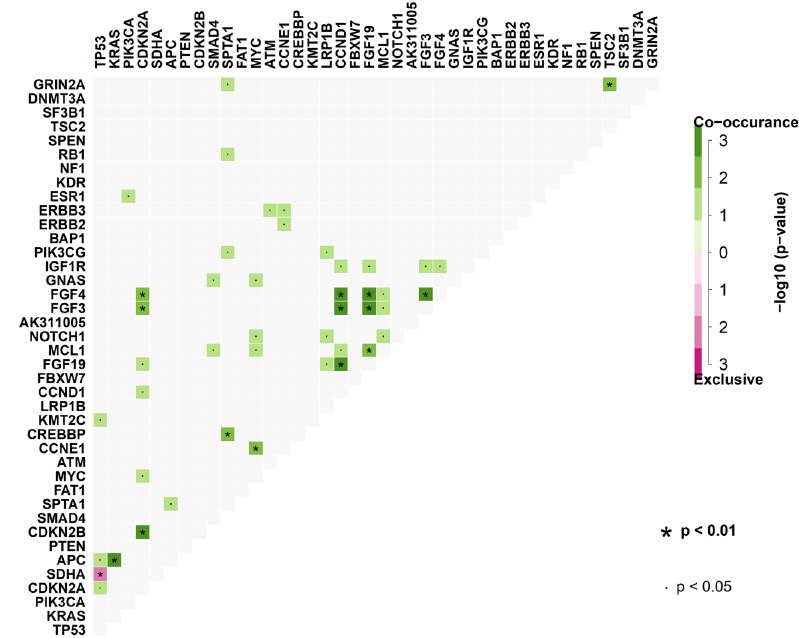
Fig. 3 Interaction of hotspot